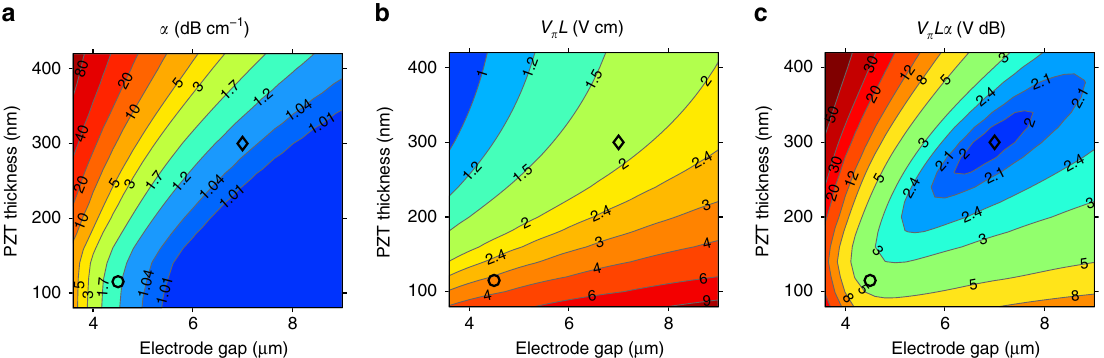
Fig. 4 Numerical optimization of a PZT-on-SiN phase modulator. Simulation of the waveguide loss α ( a ), the half-wave voltage-length product V π L ( b ), and their product V π L α ( c ) of a PZT-covered SiN waveguide modulator of the type shown in Fig. 1c, for a wavelength of 1550 nm. Waveguide height, width, and intermediate layer thickness are, respectively, 300 nm, 1.2 μ m, and 20 nm. The intrinsic waveguide loss (in the absence of electrodes) was taken to be 1 dB cm − 1 , and the effective electro-optic Pockels coef fi cient was 67 pm V − 1 . The circles show the approximate parameters used in this work, and the diamonds show the optimal point with respect to V π L